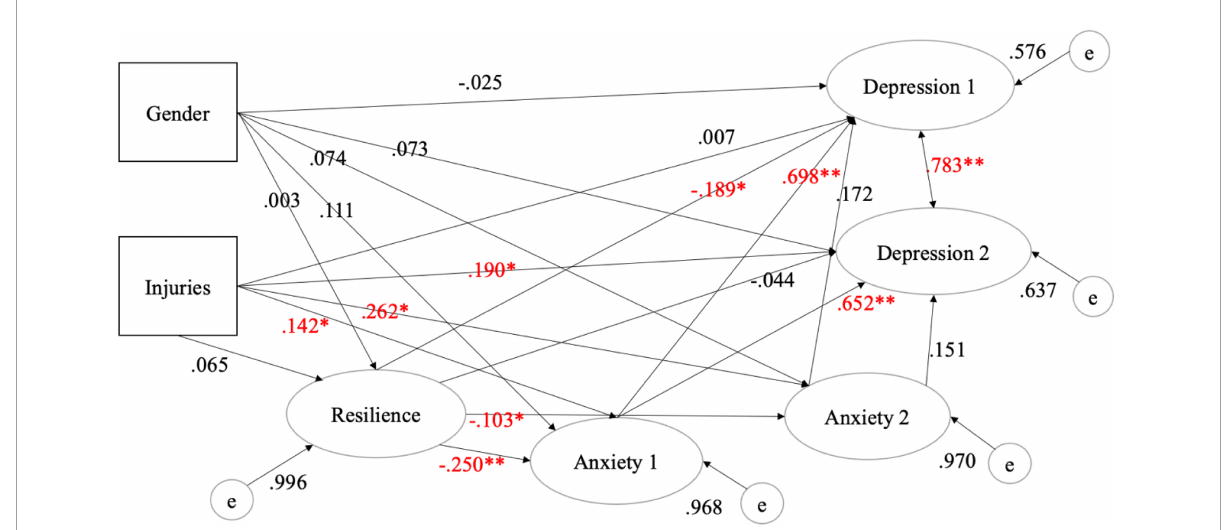
FIGURE2 The final structural equation model on resilience, anxiety, and depression ( ∗ p ≤ 0.01, ** p ≤ 0.001). Anxiety 1: cognitive factor, Anxiety 2: somatic factor, Depression 1: somatic factor, and Depression 2: cognitive factor.